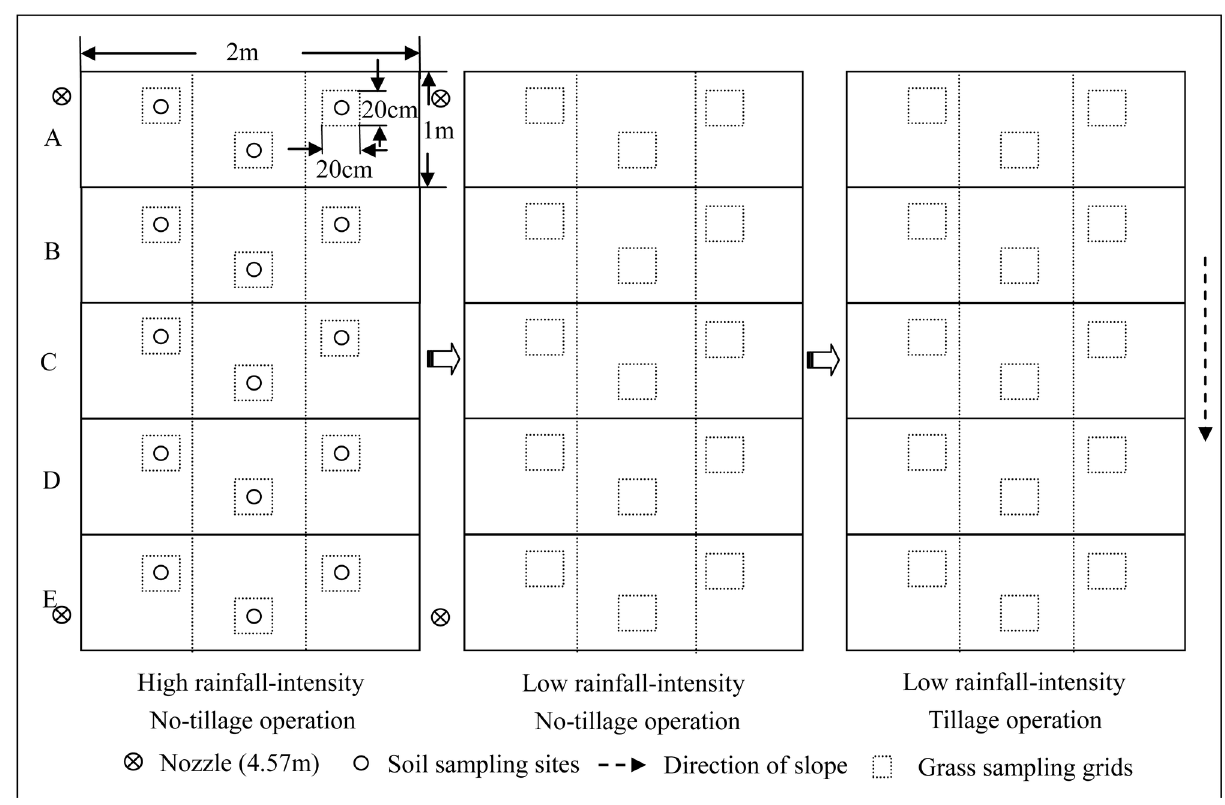
Figure 2. Design of blocks and sampling strategy of the simulated rainfall and grass planting experiments. doi: